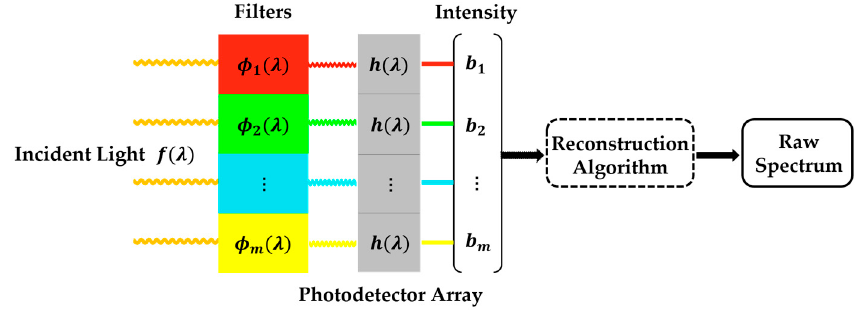
Figure 1. Schematic of the filter-based spectrometer.